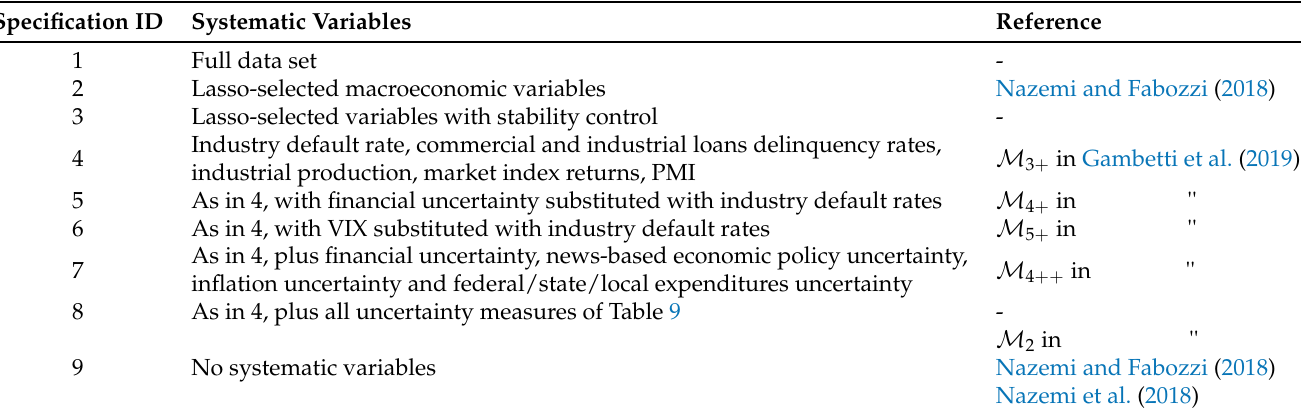
Table 10. Description of the different model